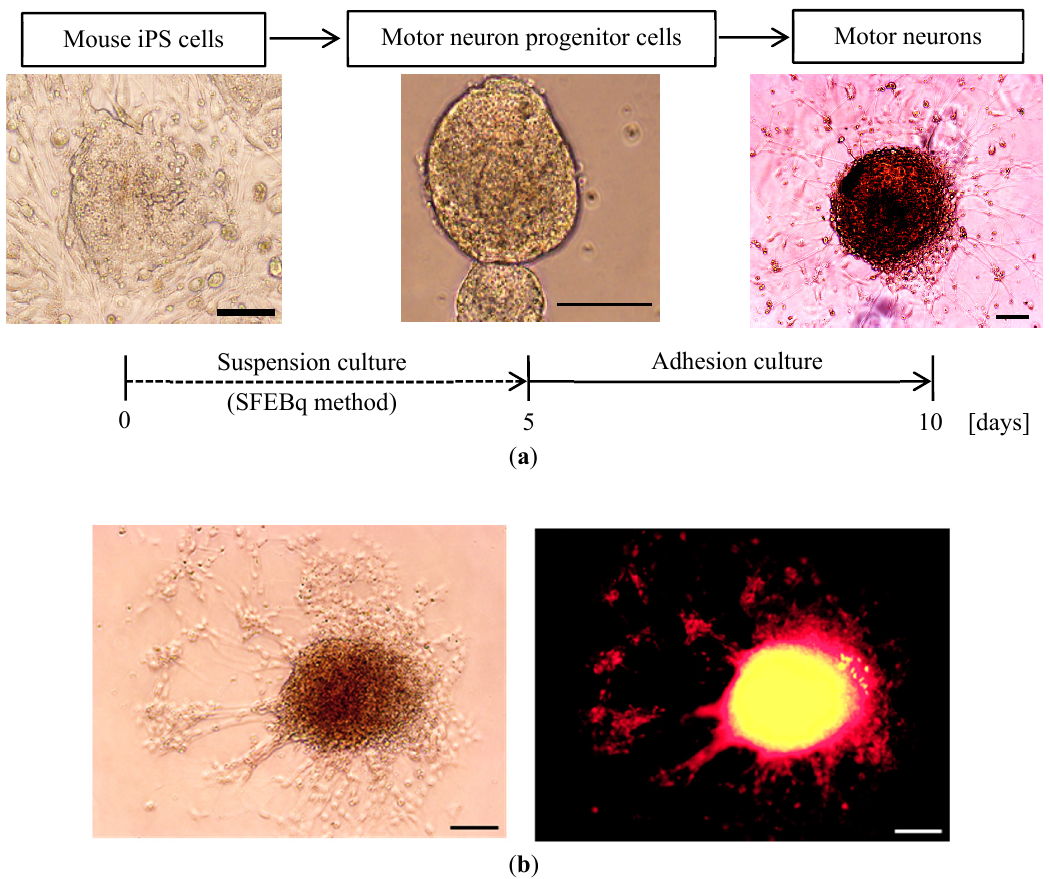
Figure 2. ( a ): Differentiation procedures from mouse iPS cells into motor neurons. By way of motor neuron progenitor cells, motor neurons are formed, and neurites start to sprout from the colony in all directions after about 10 days. ( b ): Typical differentiating mouse neuronal cell colony (at Day 8) from iPS cells. Left side figure: Light phase-contrast micrograph. Right side figure: Stained image of HB9 the motor neuron-specific transcription factor by using Mouse Anti-MNR2 antibody. The stained image is observed under the phase-contrast microscope with excitation light of 546 nm wavelength. Cell body of the motor neuron is coloured in red. It is confirmed that the differentiated neuronal cells are positive for HB9 staining. (Scale bars = 100 µm).